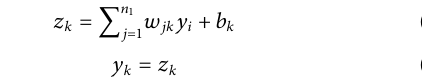
algorithm of the decision tree model, classi fi cation and regression